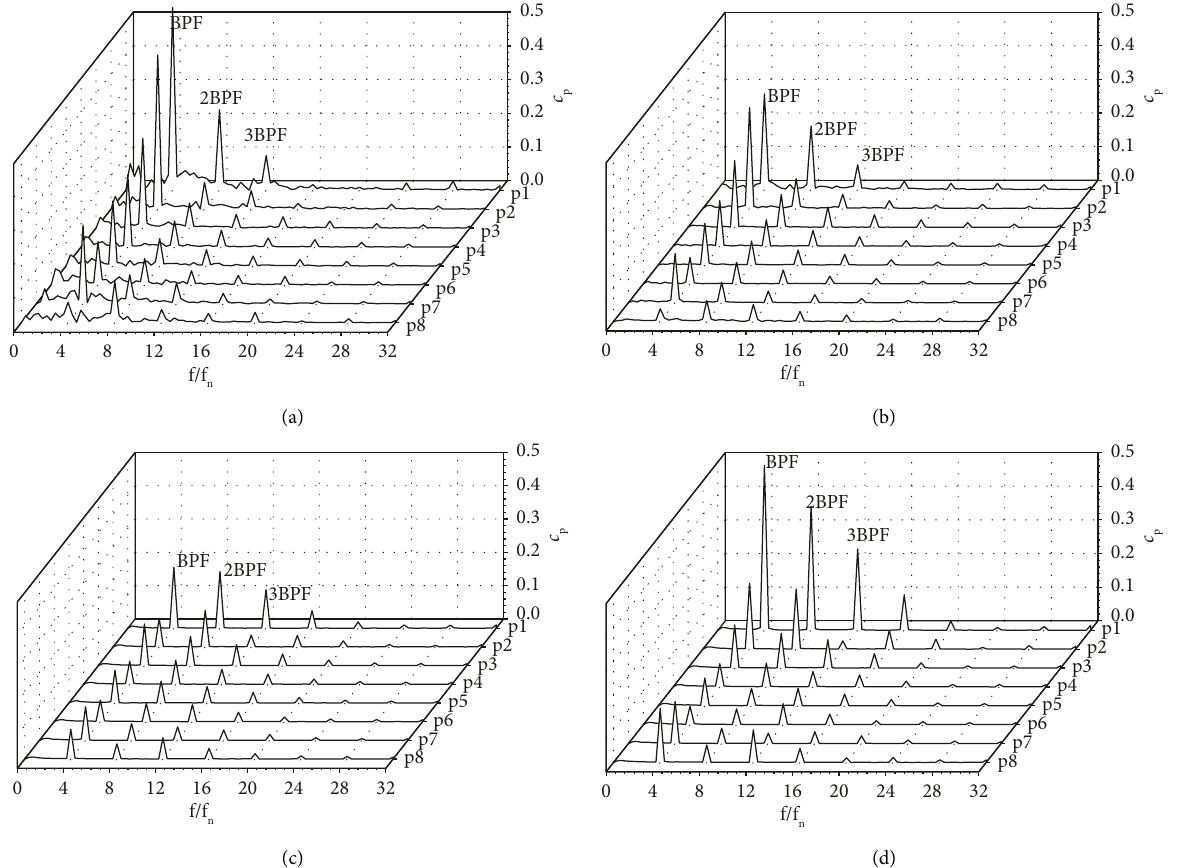
Figure 12: Pressure fluctuation amplitude in the frequency domain. (a) 0.4 Q